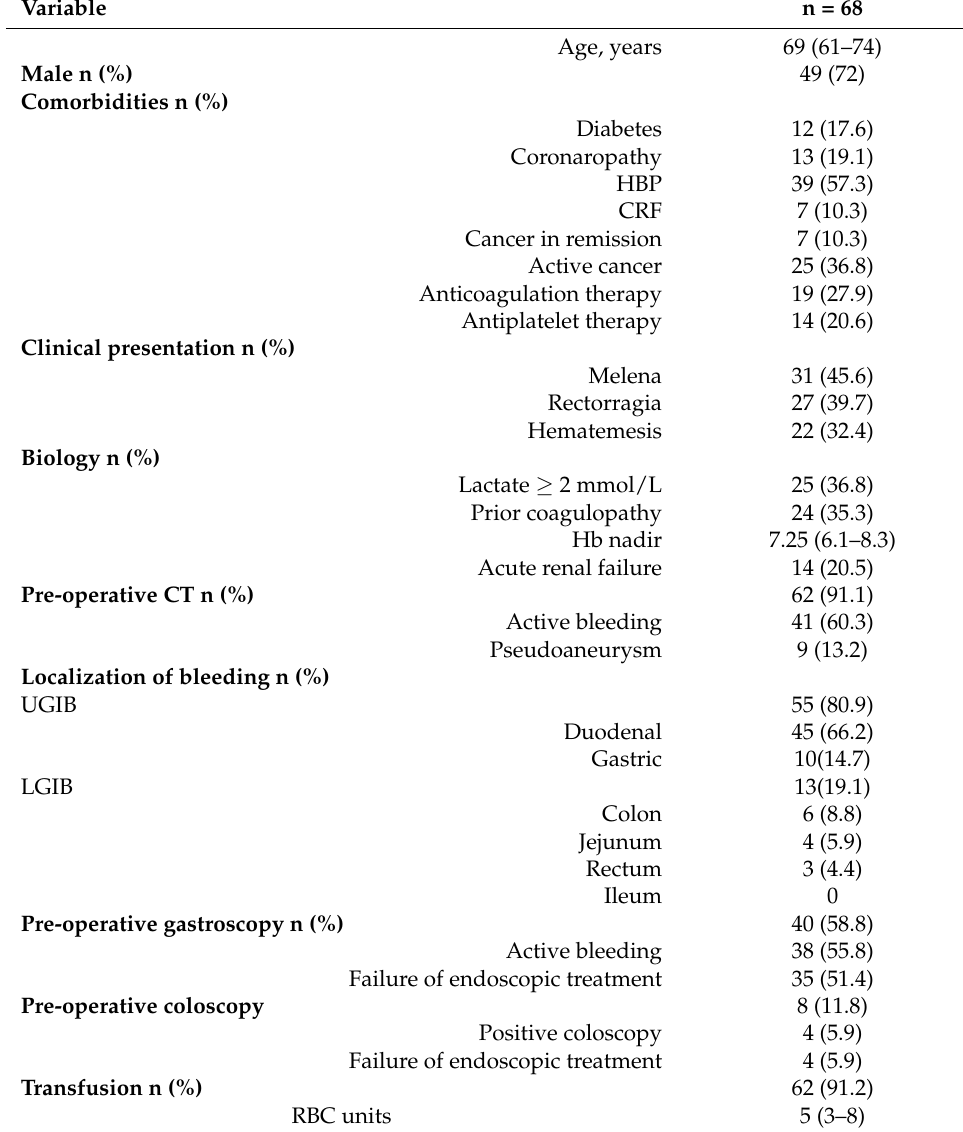
Table 1. Characteristics of the 68 patients included in the